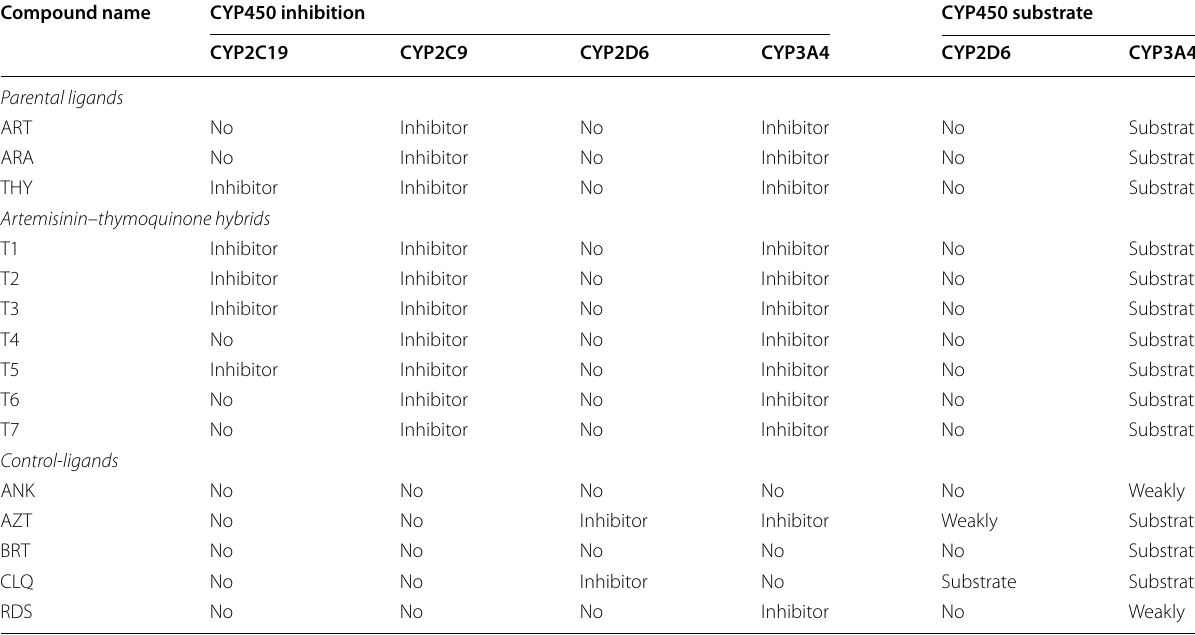
Table 3 Metabolism prediction of ART-THY hybrids, parental and control compounds